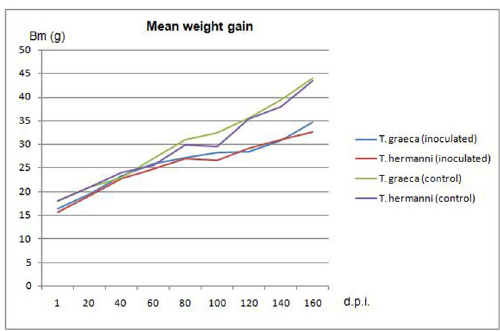
Fig 3. Mean weight gain in the groups during the survey